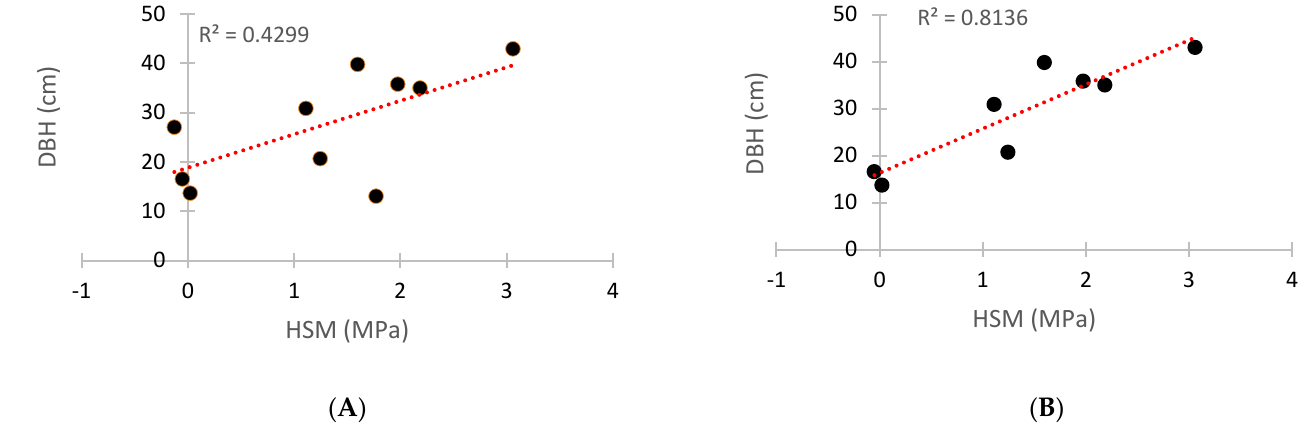
Figure 7. Relationship between DBH and HSM of species sampled in RJA. ( A ) Relationship of DBH and HSM of all measured trees; ( B ) Relationship of DBH and HSM excluding two outlier points. The functional attributes of drought tolerance, such as P 50 , π TLP and isohydricity, show a trend of moderate drought tolerance for the study plot. When evaluated by stem diameter, thinner trees show less resistance to